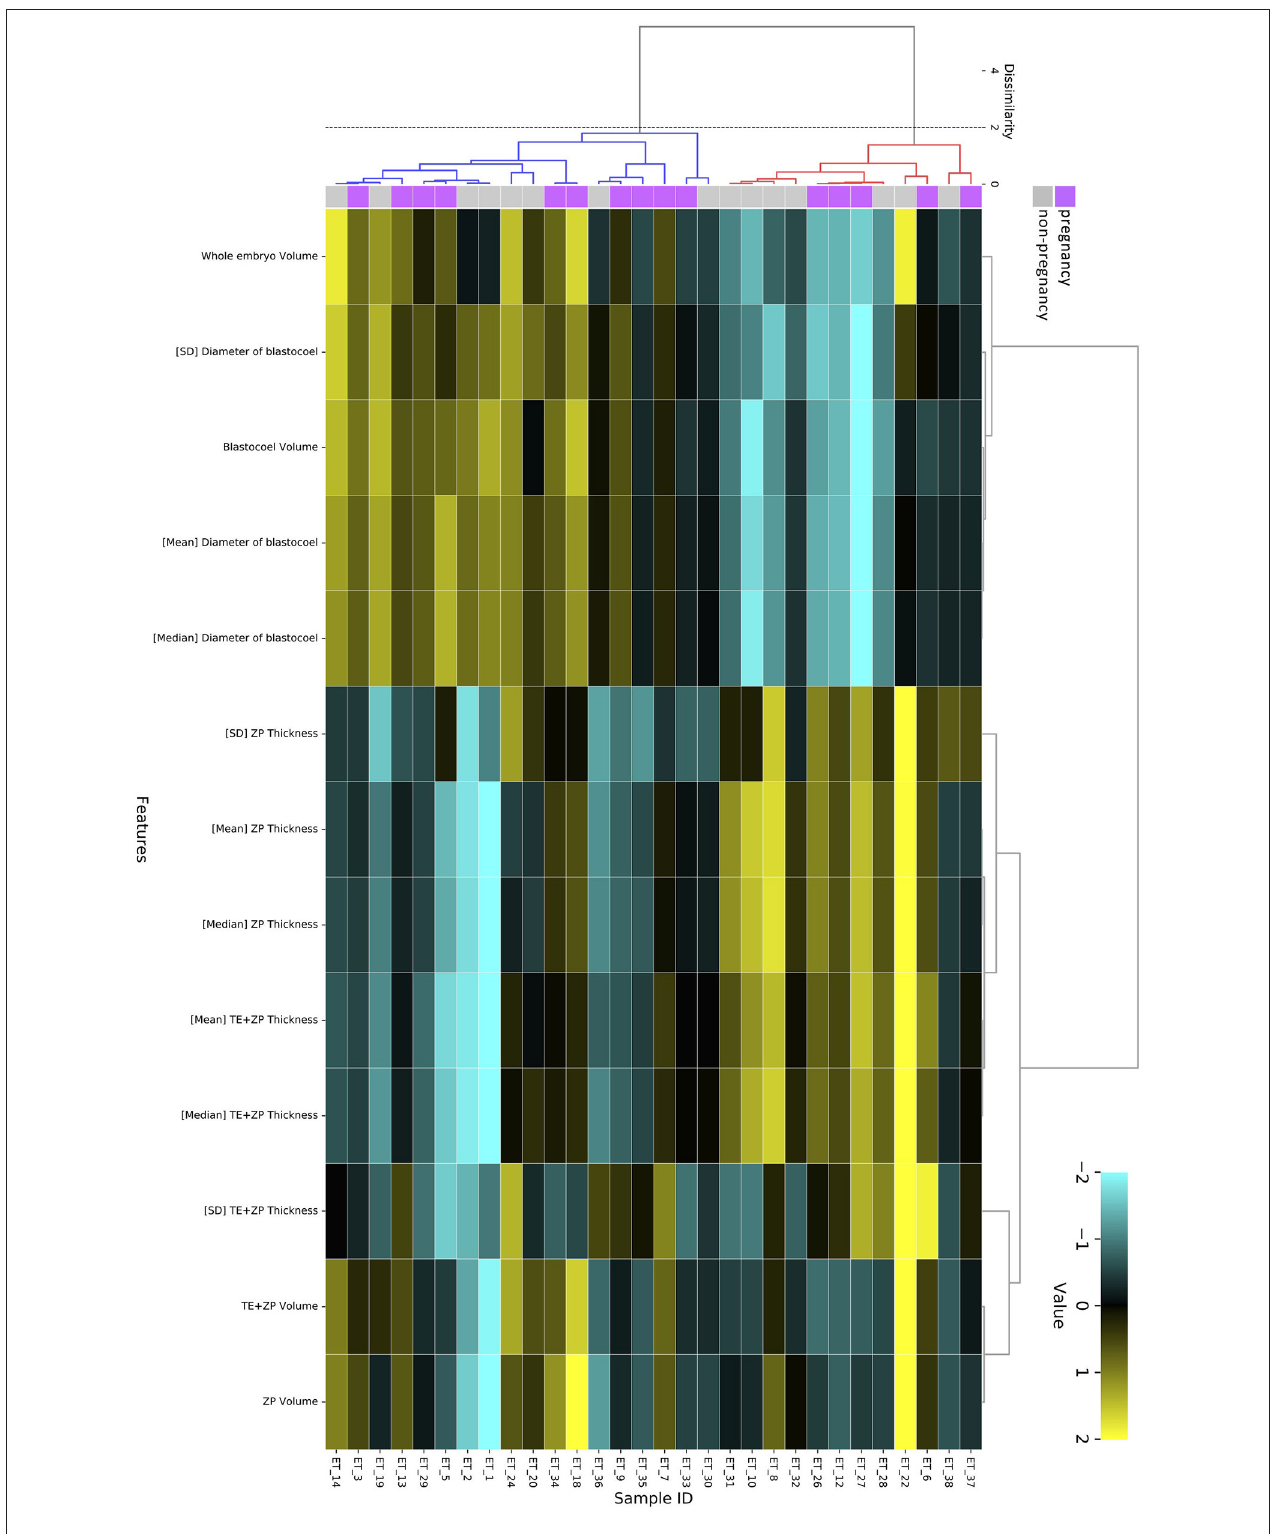
FIGURE 10 | Hierarchical clustering analysis performed using 13 blastocoel-related and ZP-related parameters obtained from 30 blastocysts applied for transfer [pregnancy (purple): n = 15, non-pregnancy (gray): n = 15]. Embryos displaying similar patterns for these 13 parameters were grouped together on closely